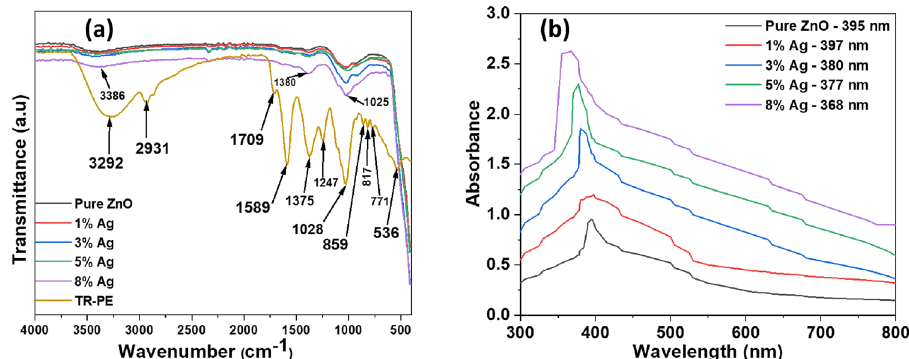
Figure 3. ATR-FTIR spectra of ( a ) Tetradenia riperia plant extract (TR-PE), pure ZnO and Ag–ZnO nanocomposites at different Ag concentrations ( b ) UV–Vis spectra pure ZnO-NPs and Ag–ZnO nanocomposites doped with different concentrations of Ag